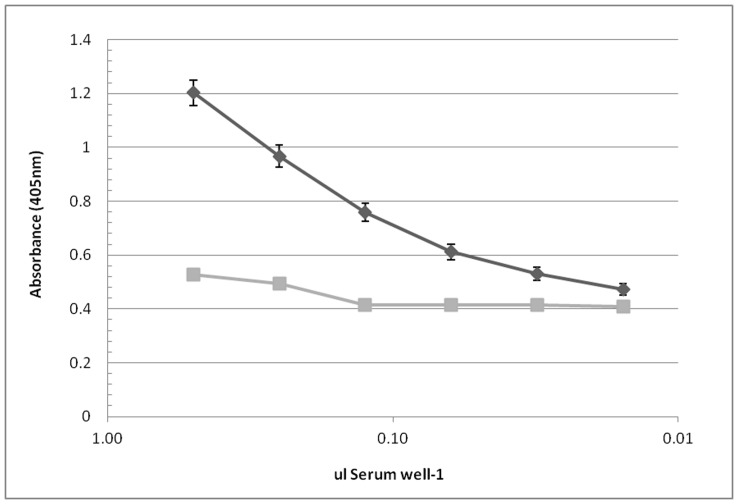
AntiCardicola ELISA of positive (♦) and negative (▪) controls of T. maccoyii serum; mean ± SE of 15 observations.